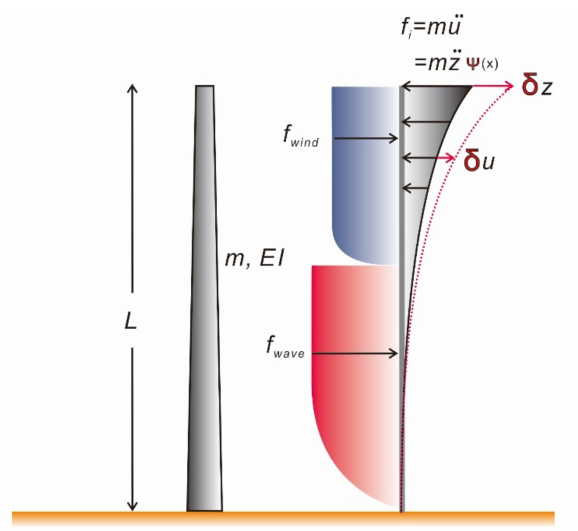
Figure 9. O ff shore wind turbine substructure deflections and virtual displacement with fictitious inertia